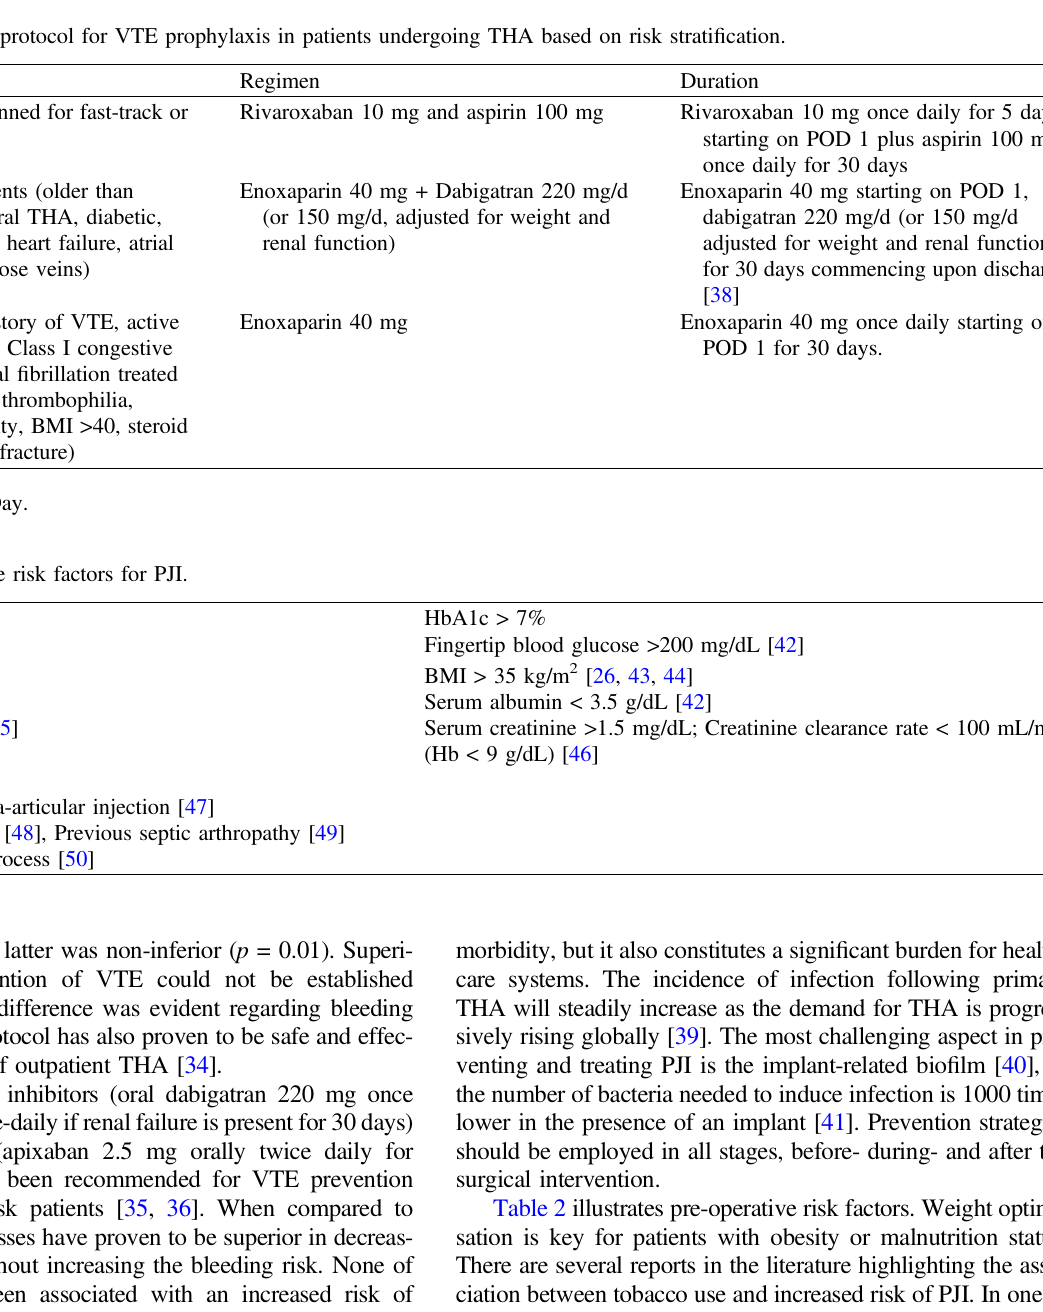
laxis in patients undergoing THA based on risk strati fi cation. Preventing prosthetic joint infection Prosthetic joint infections (PJI) after total hip arthroplasty